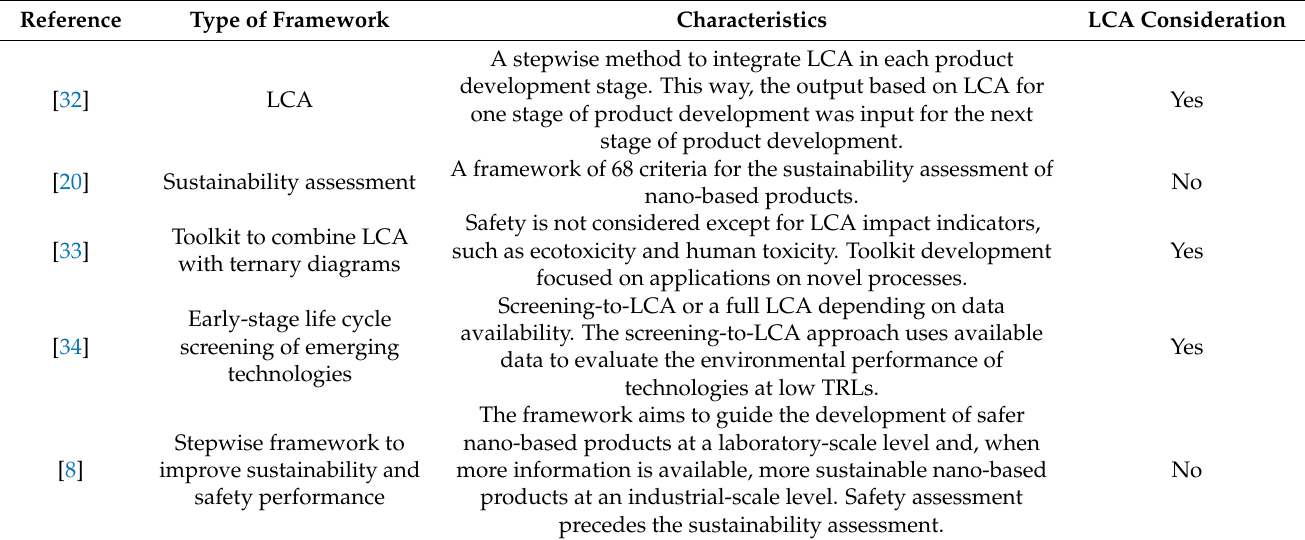
Table 1. Literature review of sustainability assessment frameworks for NMs and